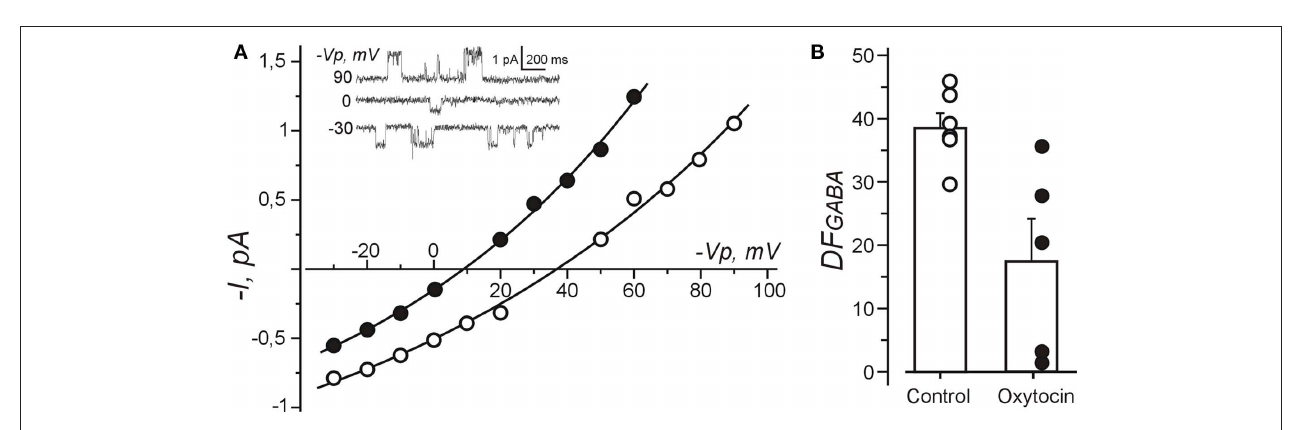
presence of oxytocin (1 µM). Examples of recordings at different pipette potentials ( V ) are shown on inset. (B) Summary plot shows the values of p DF in control conditions and in the presence of oxytocin. Each circle GABA corresponds to individual neuron. Note that oxytocin reduces DF trigeminal